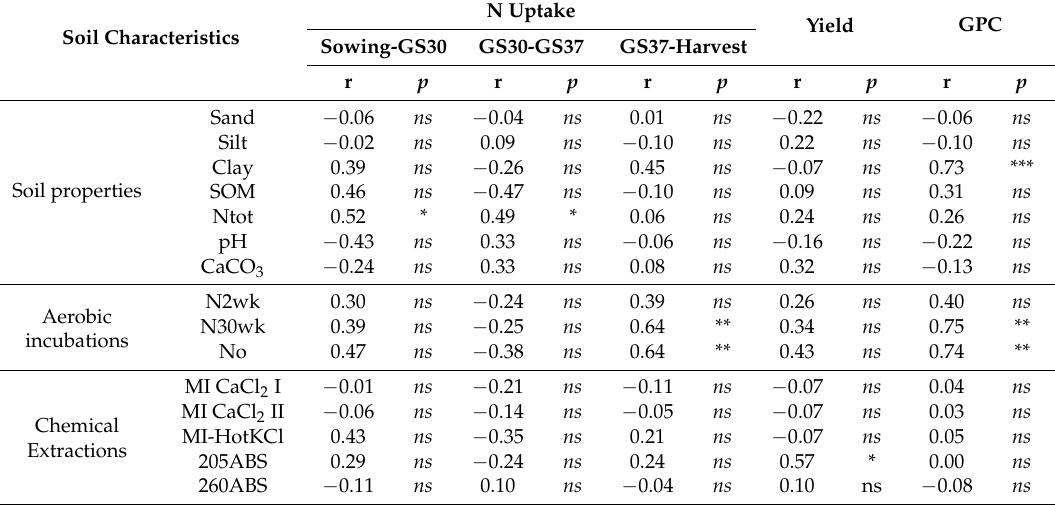
Table 4. Pearson correlation coefficients (r) among soil properties, N mineralization indices calculated from the aerobic incubations and chemical extractions with N uptake values between sowing and stem elongation (GS30), GS30 and leaf flag emergence (GS37), GS37 and flowering (GS60), and yield and GPC (grain protein